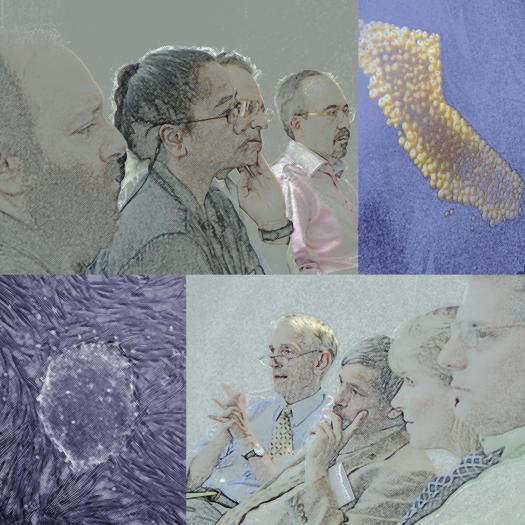
CIRM developed comprehensive medical and ethical standards for stem cell research through a process involving extensive expert and public consultation.(Credit: The Burnham Institute & CIRM)